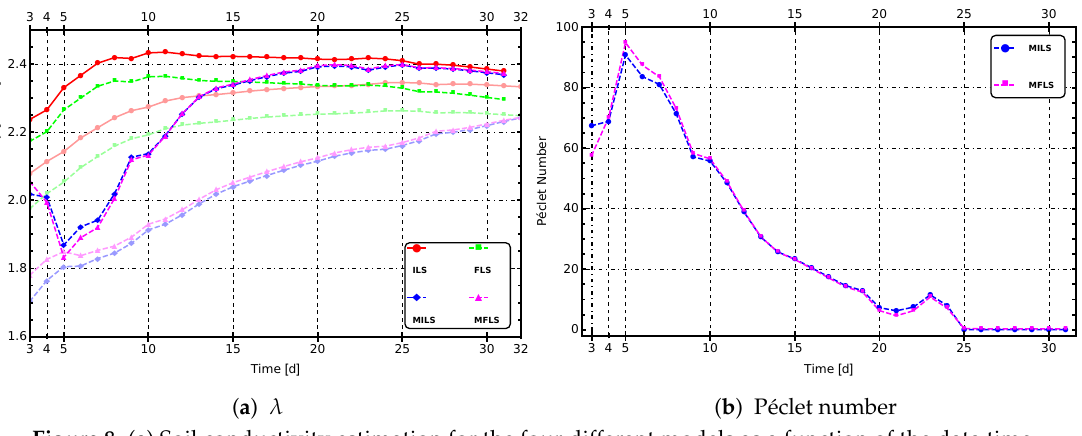
Figure 8. ( a ) Soil conductivity estimation for the four different models as a function of the data time window used with data only from day 1. ( b ) Péclet number estimation for the four different models as a function of the data time window